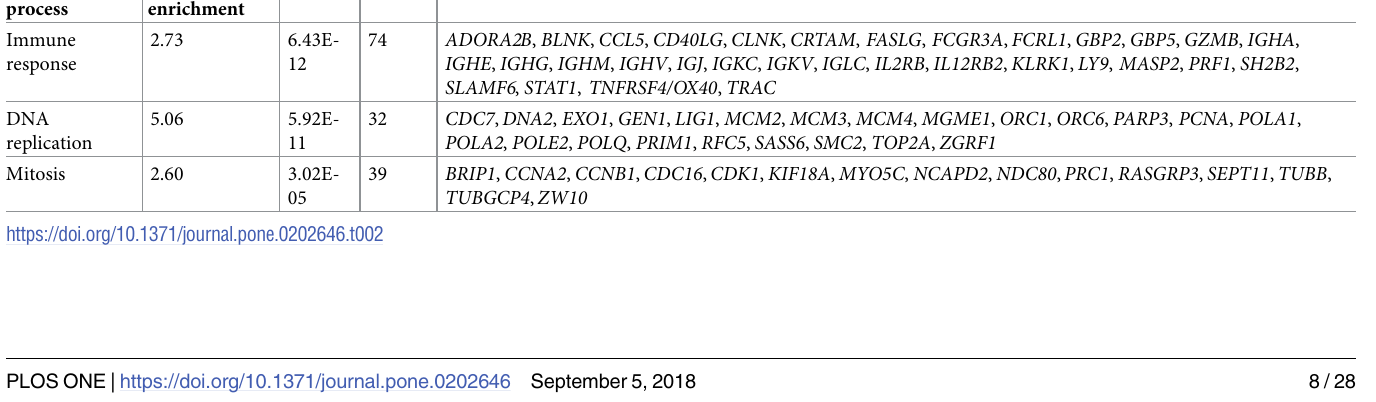
Table 2. Enrichment analysis of 897 genes with statistically significant increased expression in foal samples between days 1 and 42. Biological fold process